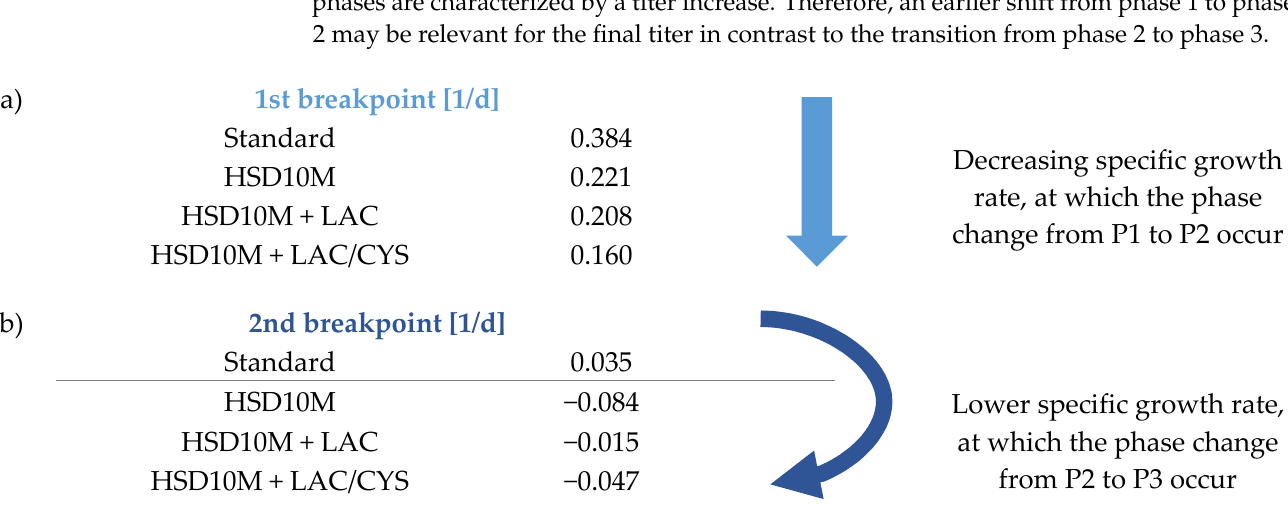
Figure 4. Comparison of identified breakpoints with the method segmented linear modeling for the processes: standard (2), HSD10M without supplementation (5), HSD10M with LAC supplementation (3) and HSD10M with LAC/CYS (2) supplementation. The number in the brackets shows the number of runs which were used for this analysis. First breakpoint is shown in ( a ) and the second breakpoint is shown in ( b ). STD, standard process with seeding density of 0.7 × 10 6 cells/mL; HSD10M, process with the seeding density 10 × 106 cells/mL; +LAC, supplemented with lactate; +LAC/CYS, supplemented with lactate and cysteine. The light blue arrow shows that the value of the first breakpoint decreases from the STD process to HSD10M, HSD10M + LAC and finally to HSD10M + LAC/CYS. The dark blue arrow shows that the second breakpoint is at higher specific growth rates in the STD process compared to the other process types with HSD10M.